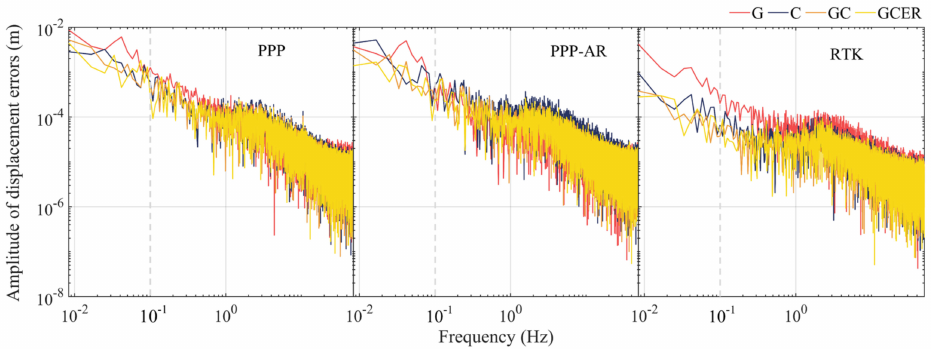
Figure 7. Amplitude–frequency spectra of displacement errors from quasi-static motion test com- puted with observations from the different satellite systems G, C, GC, and GCER, respectively. From left to right, results from PPP, PPP-AR, and RTK.